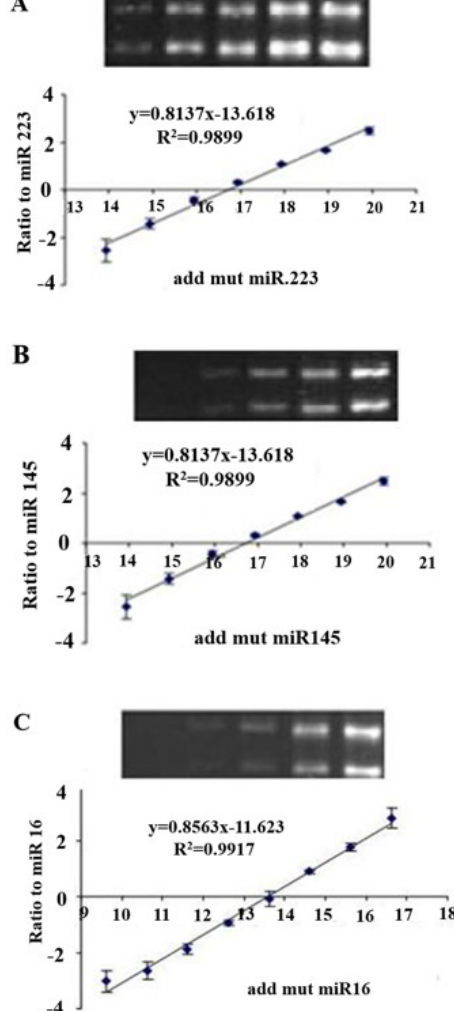
Fig. 2. Co-amplification of miRs and standard plasmid: (A) 10 5 copies of miR-223 and standard plasmid; (B) 10 7 copies of miR-145 and standard plasmid; (C): 10 6 copies of miR-16 and standard plasmid. Similar plot patterns were observed in a replicate